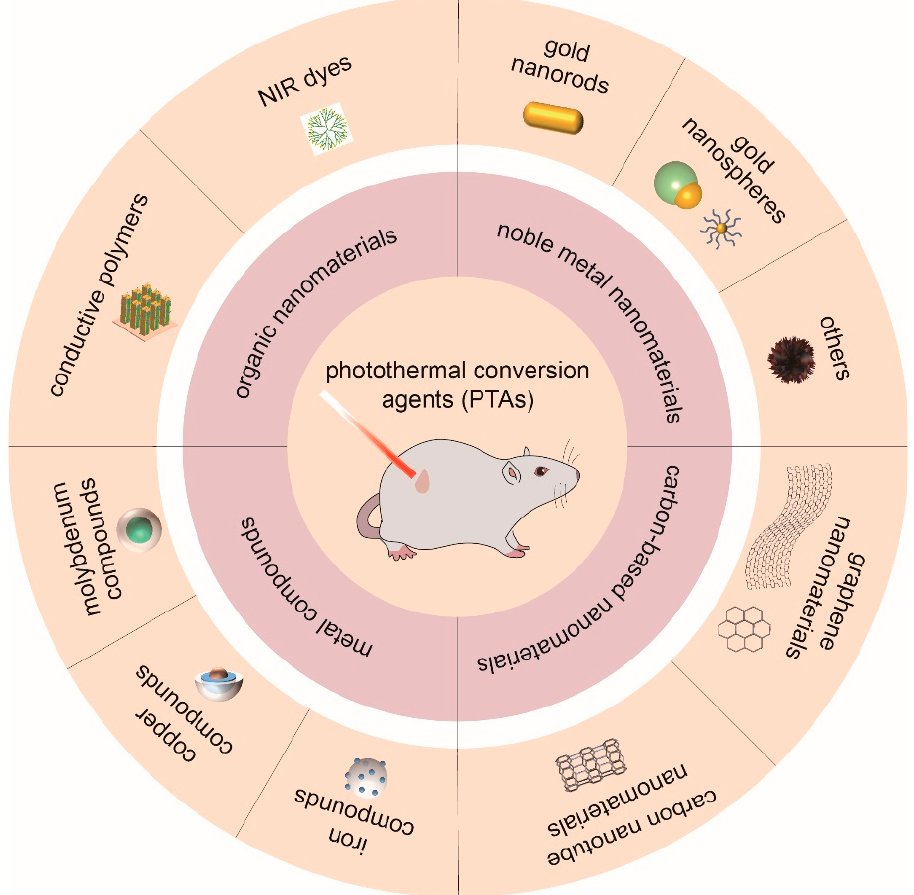
Figure 1. Classification and delivery systems of nanomaterials for photothermal therapy (PTT) in oral squamous cell carcinoma (OSCC).